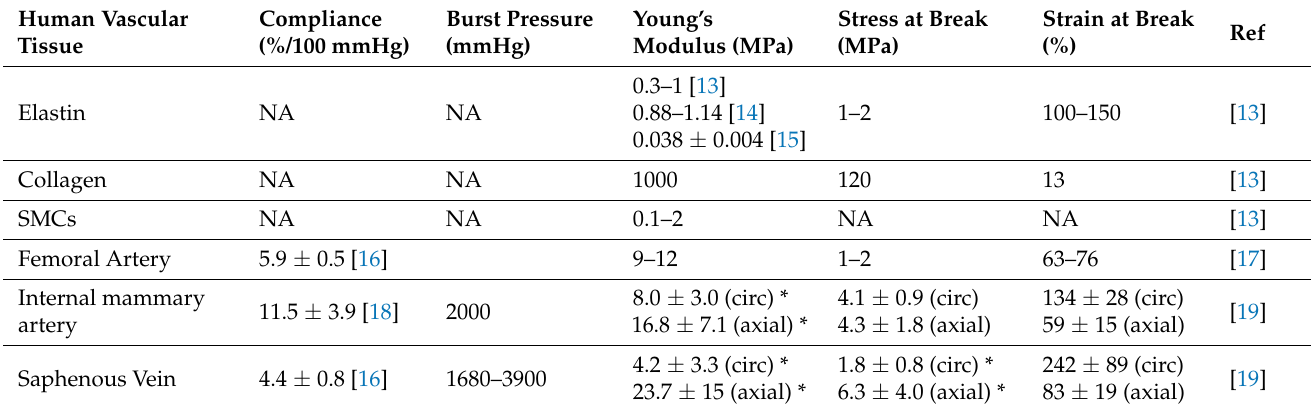
Table 1. Mechanical properties of blood vessels wall’s components (elastin, collagen, and SMCs) and some blood vessels (adapted from